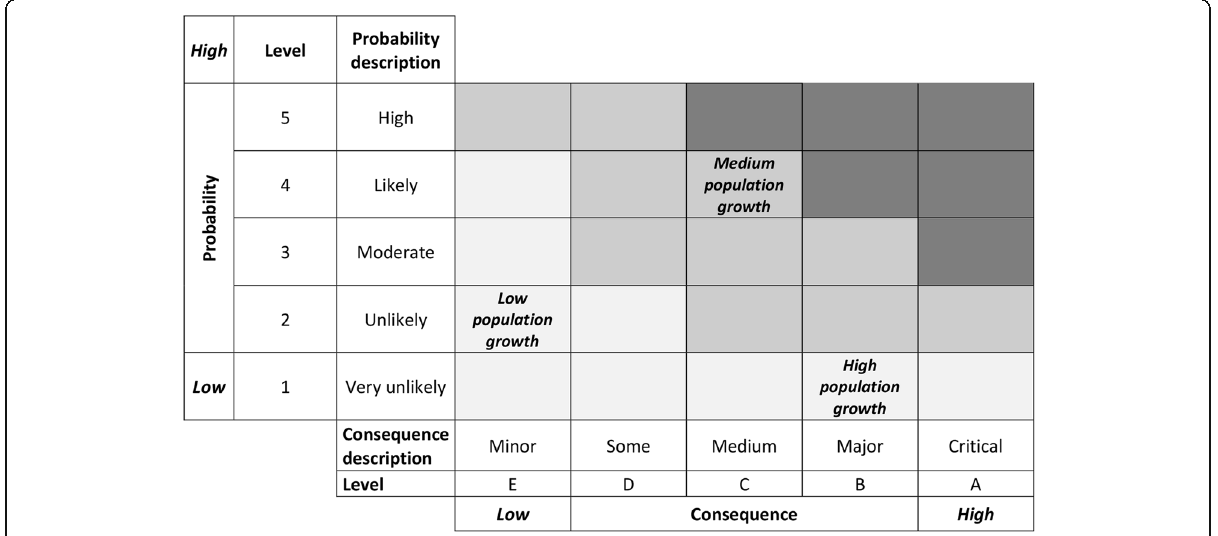
Fig. 1 Example of consequences and probabilities of future population growth scenarios used in risk analysis and risk